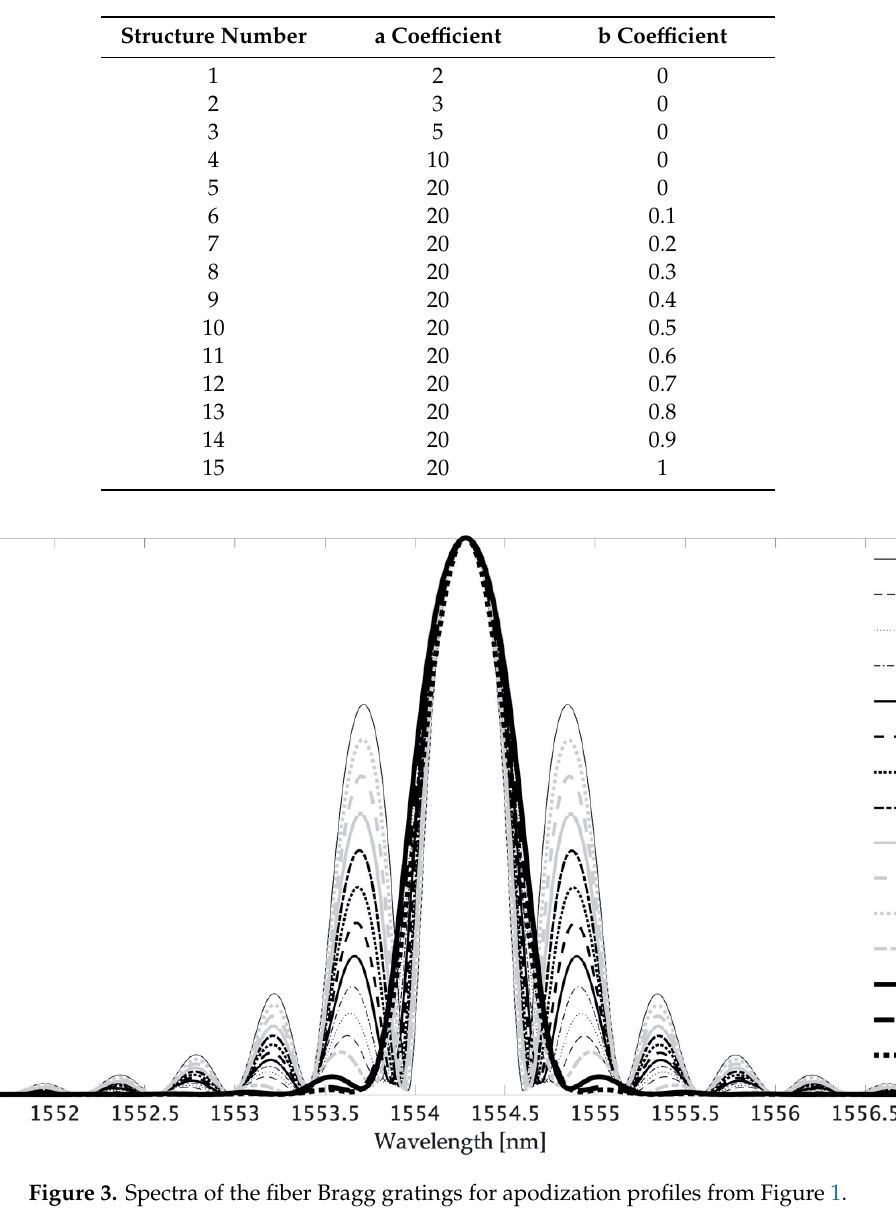
Table 1. Parameters of fiber Bragg gratings calculated for analysis.